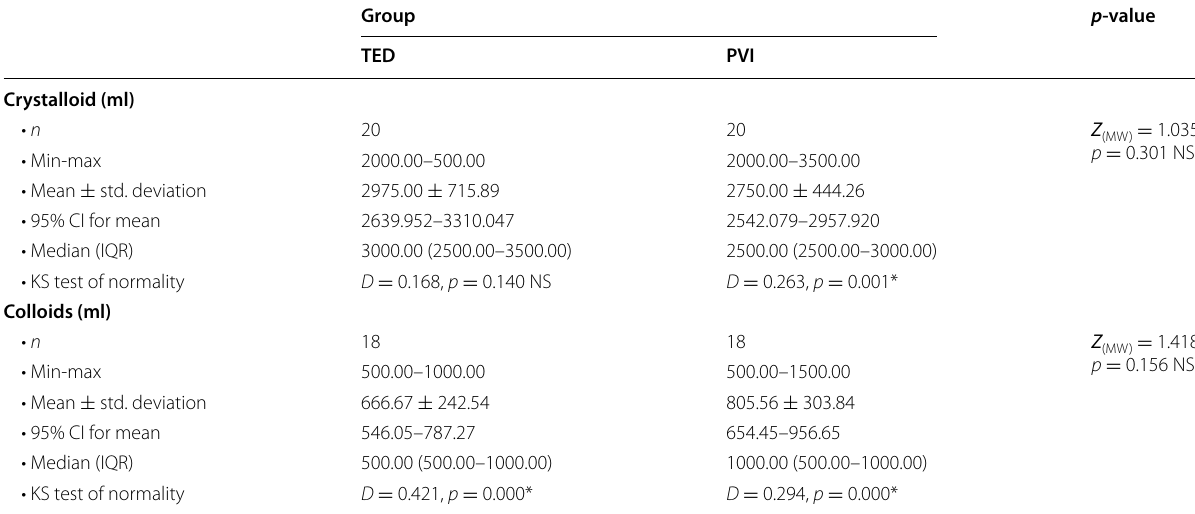
Table 3 The volume of intraoperative guided infusion of crystalloids and colloids in transesophageal Doppler (TED) group versus pleth variability index (PVI)